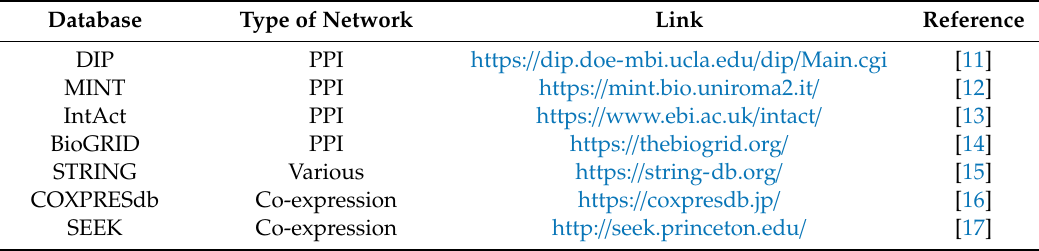
Table 1. Some of the most popular databases of biological